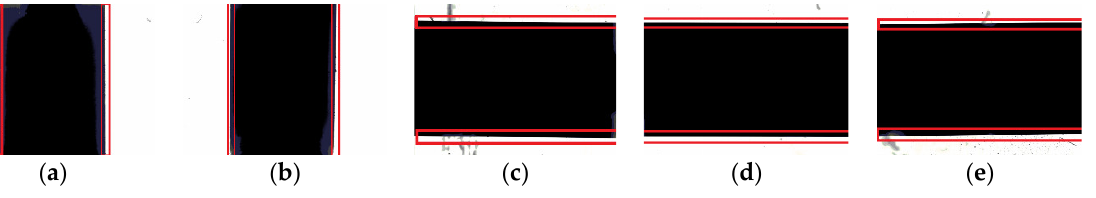
Figure 15. Simultaneous imaging of five cameras. ( c – e ) were the pictures imaged by cameras 1, 2 and 5; ( a , b ) were the pictures imaged by cameras 3 and 4.